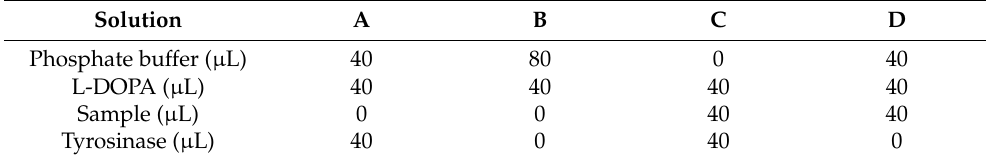
Table 1. The proportion of reactant solutions.